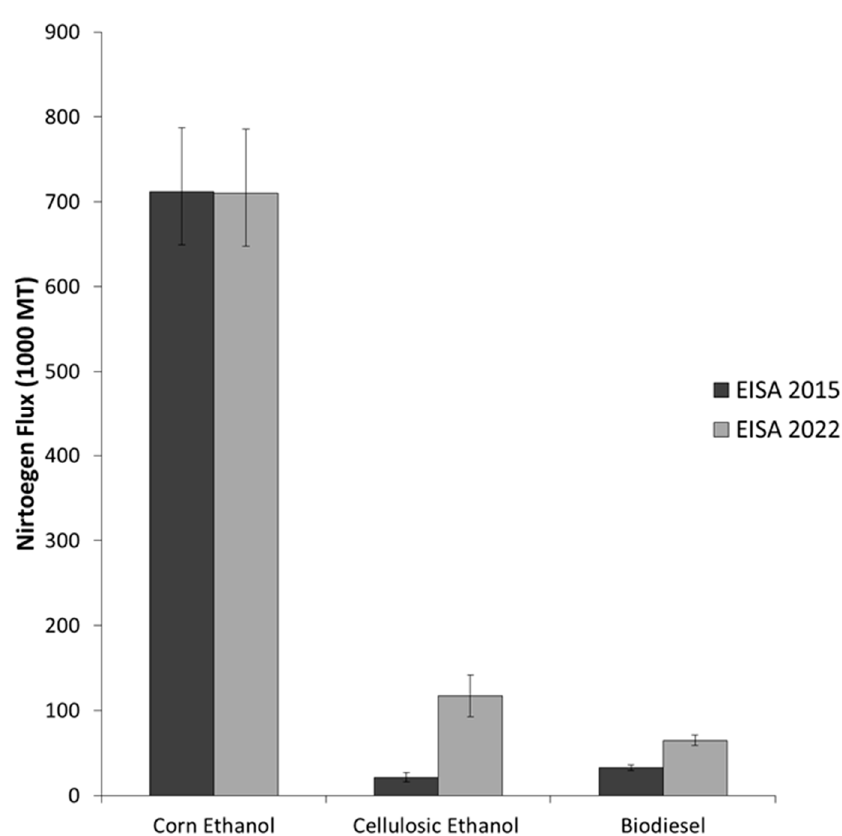
Figure 3. Nitrogen flux by fuel type for EISA mandates 2015 and 2022.